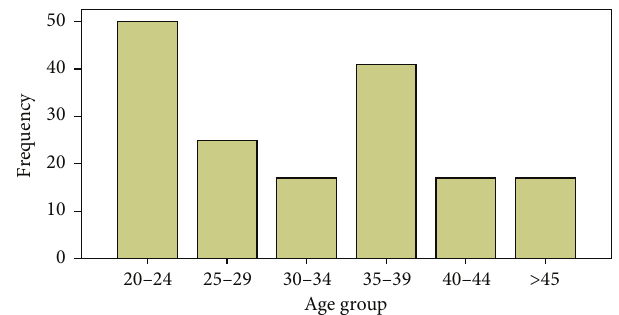
Figure 1: Age groups of inmates in the Ogbomoso Prison,